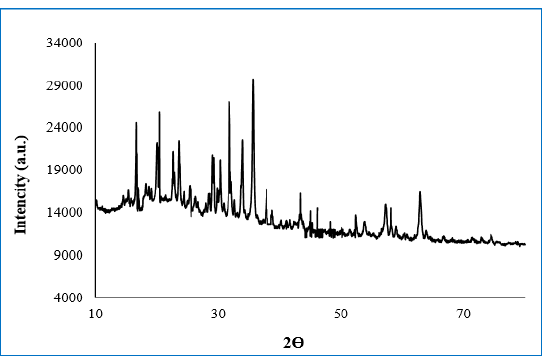
Figure 6. XRD patterns of IM-PL on magnetic lily NPs.